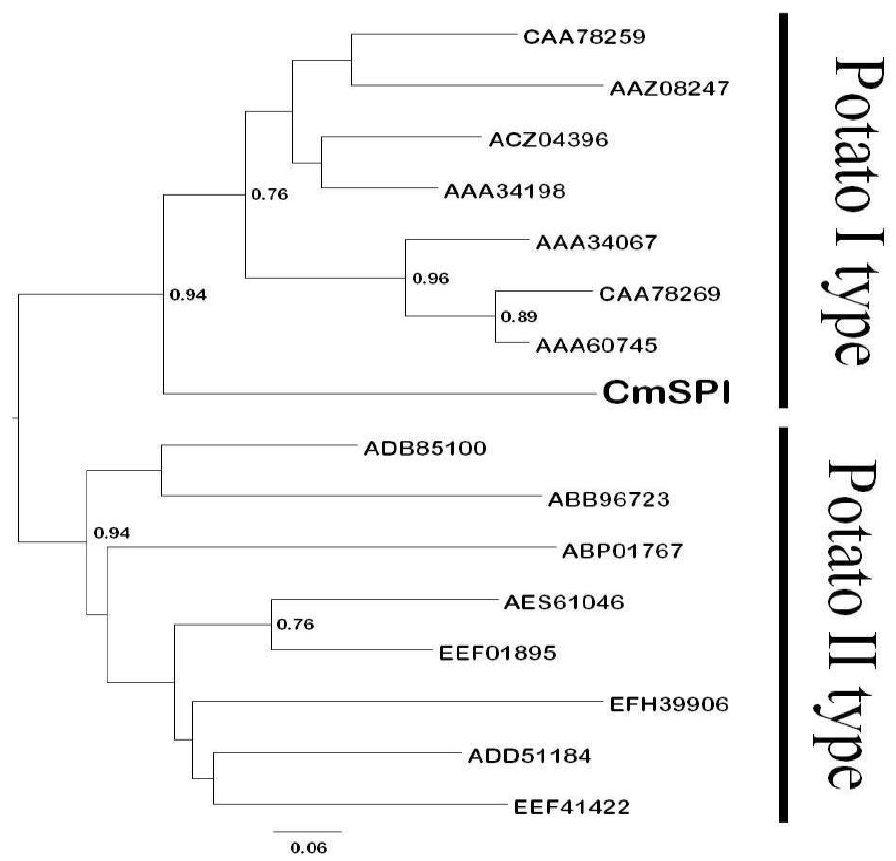
Figure 2. Neighbor-joining reconstruction of the phylogenetic relationships among plant serine proteinases inhibitors. Bootstrap values for nodes supported in >70% of 100 bootstrap replicates are shown above the branches. The scale bar shows the ratio of amino acid substitutions for a given horizontal branch